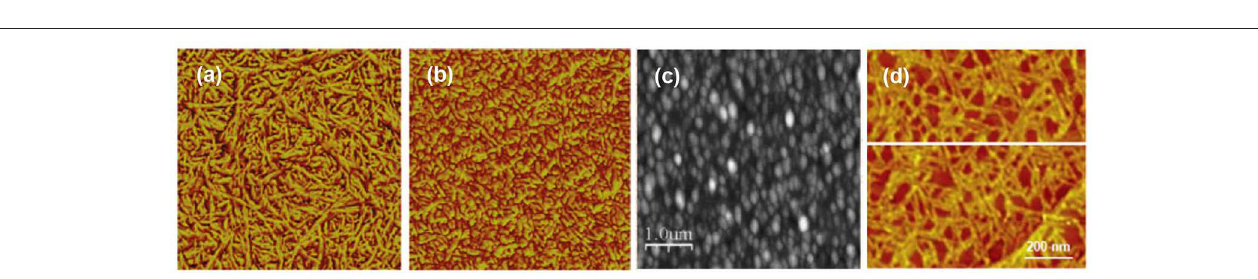
FIGURE 1 | Schematic representations of (A) plant cell, (B) semi-crystalline cellulose microfibril, and (C) cellulose molecule.